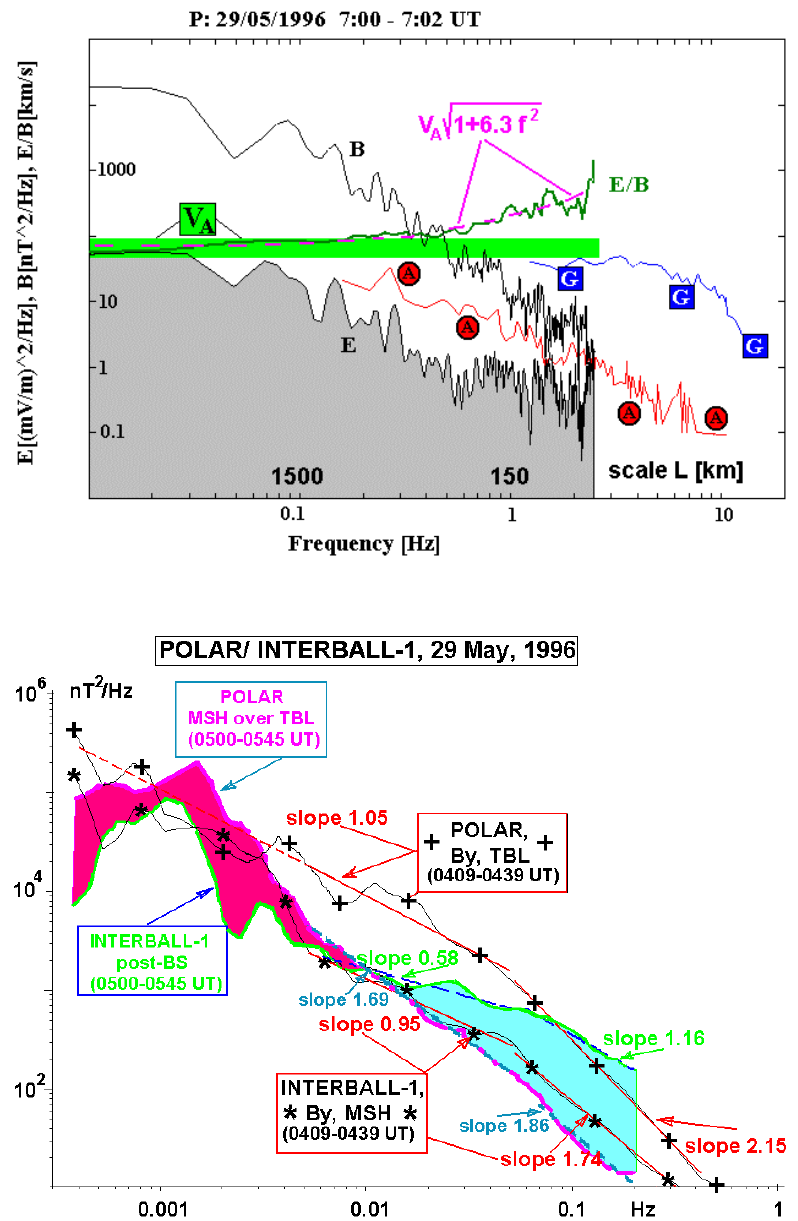
Fig. 3b. Magnetic wavelet spectra of GSM B y on 29 May 1996. Po- lar: TBL at 04:09–04:39UT (crosses, the characteristic slopes are marked by the red color) and stagnant MSH over TBL at 05:00–05:45UT (violet trace, slopes are marked by the blue color, the difference with the simultaneous post- BS spectrum from Interball-1 is shad- owed). Interball-1: MSH at 04:09– 04:39UT (asterisks, the characteristic slopes are marked by the red color) and post bow shock MSH at 05:00– 05:45UT (green